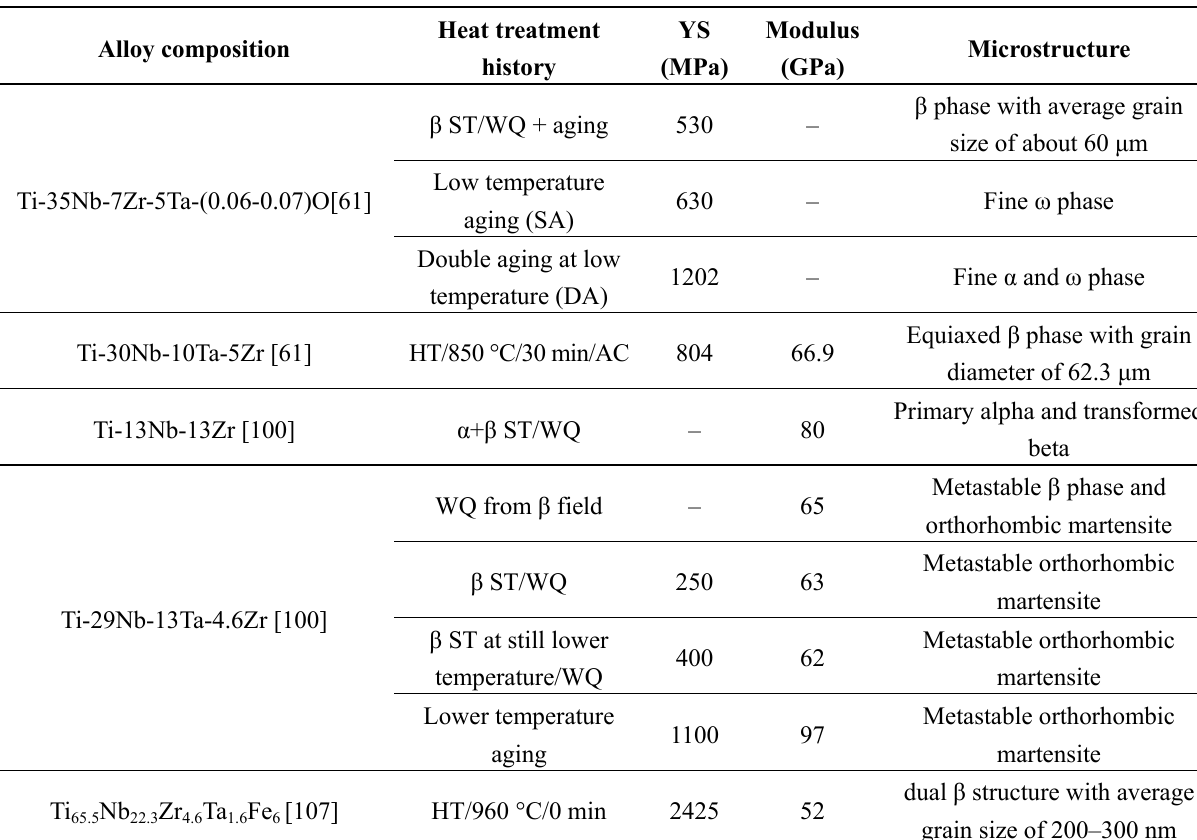
Table 6. Phases formed in β -type Ti-based alloys under different heat treatments. (SA: single aging; DA: double aging; ST: solution treated; WQ: water quenched; AC: annealed condition; HT: heat treated).